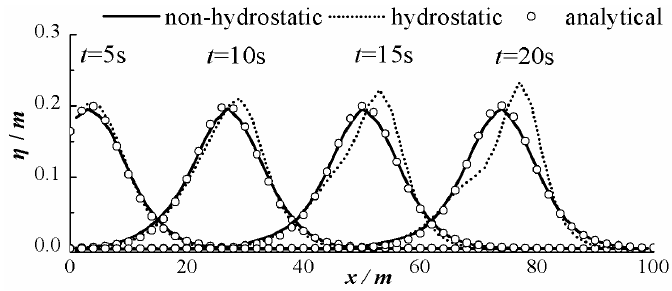
Figure 5. Simulated waveform by the non-hydrostatic (solid line) and hydrostatic model (dotted line); analytical waveform (circled) at different points in time ( t = 5, 10, 15, and 20 s).